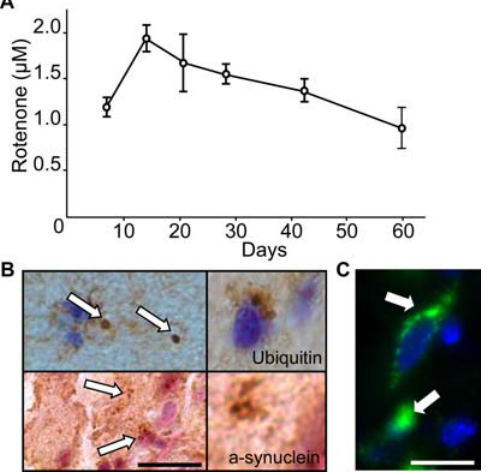
Figure 1. Characterization of the rotenone rat model. Rats received a subcutaneous injection of microspheres encapsulating rotenone. A: Concentration of rotenone in the plasma was determined on an HPLC system from 200 m l of blood samples drawn from the tail vein from 4 rats every week for 60 days. Values are given with standard deviation (SD). B: Rat brain coronal sections at the level of SN were subjected to immunohistochemical staining with antibody against a -synuclein or ubiquitin. Left panel, Lewy body-like cytoplasmic inclusions in SN neurons (arrows). Scale bar is 10 m m. Right panels, images at a higher magnification. C: The rat SN sections were stained with antibody specific for 8-oxo-dG. Oxidatively modified DNA appeared in green. Nuclei were stained in blue with DAPI. The image shows the damage to both mitochondrial DNA (left arrow) and nuclear DNA (right arrow) in SN neurons. Scale bar is 15 m